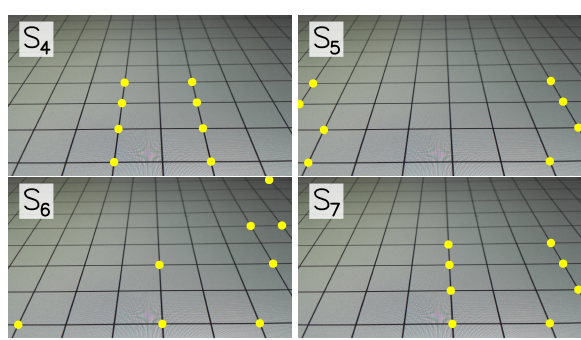
Figure 4. Subsets S 0 to S 7 , for angle A 1 , considered to analyze the influence of the GCPs distribution.